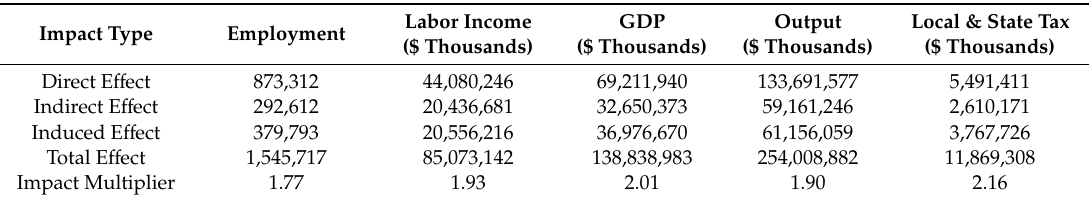
Table 6. Summary Impacts.